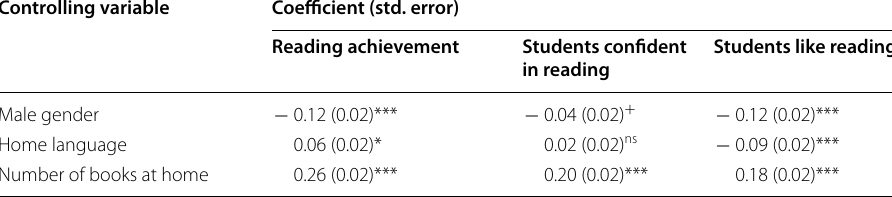
***p < 0.001; **p < 0.01; *p < 0.05; + p < 0.10; ns p